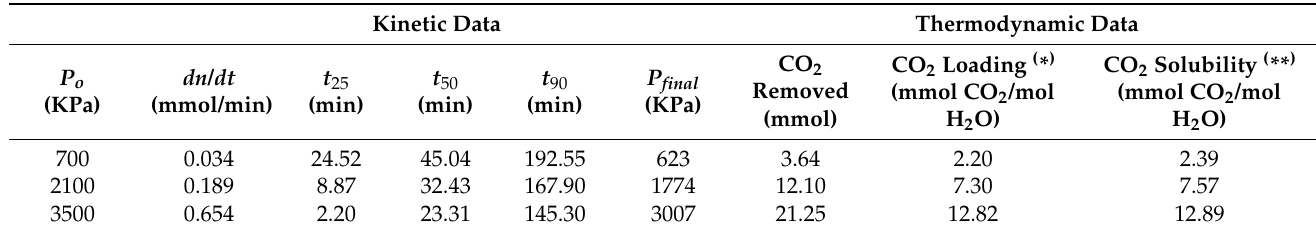
Table 1. CO 2 solubility testing: kinetic and thermodynamic data.